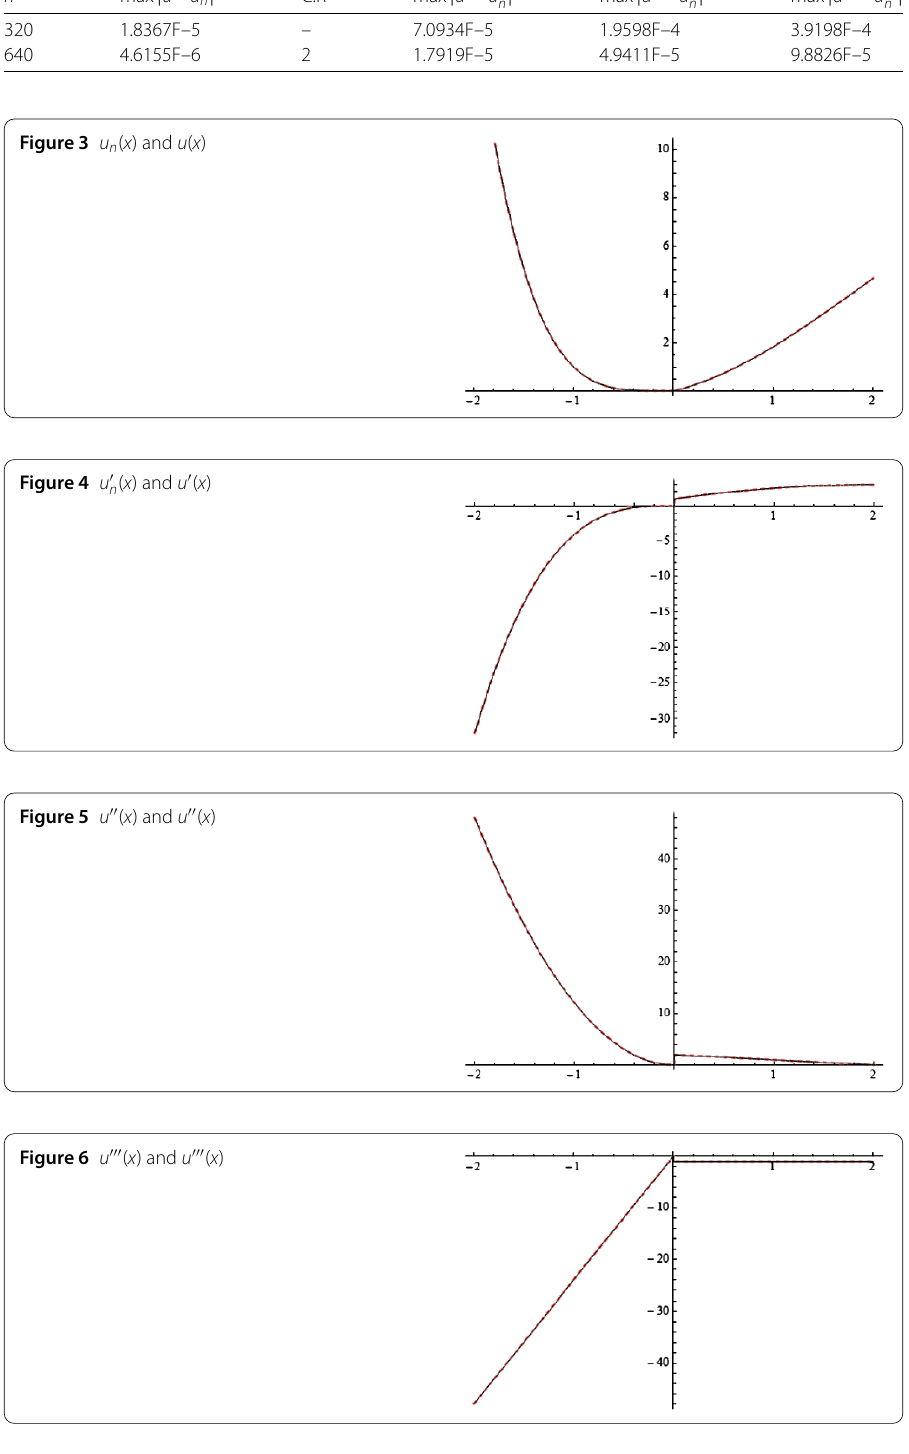
Figure 5 u (cid:2)(cid:2) ( x ) and u (cid:2)(cid:2) ( x )